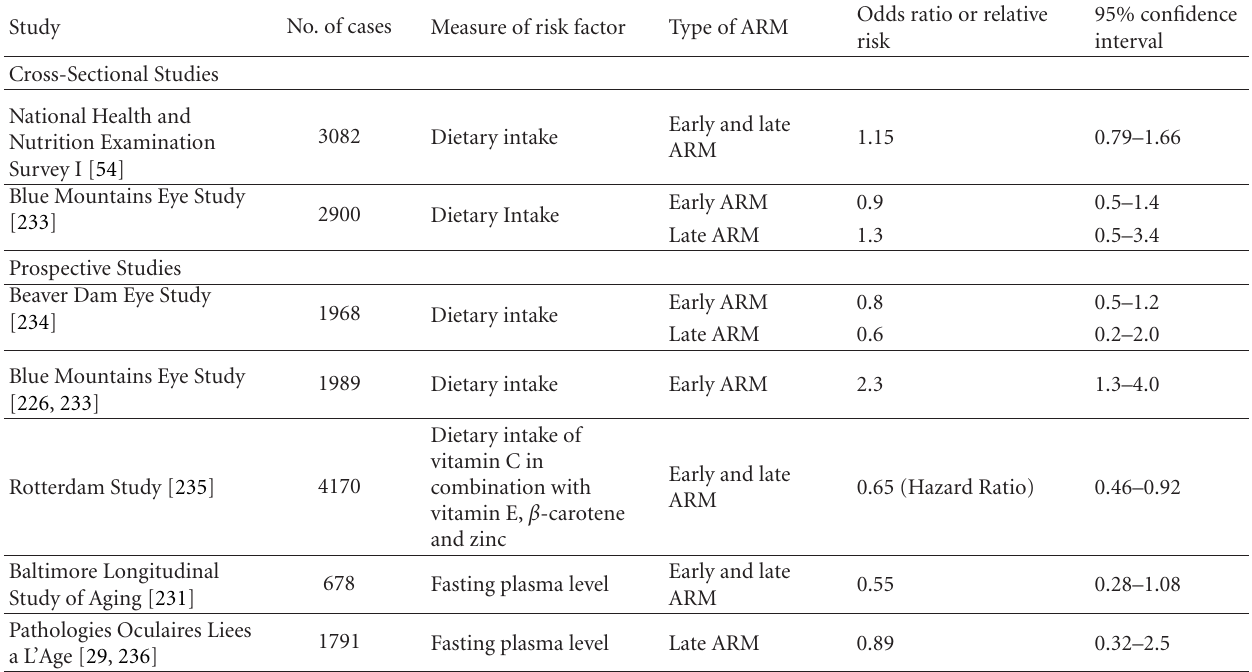
Table 9: Studies investigating the relationship between vitamin C and risk for ARM.